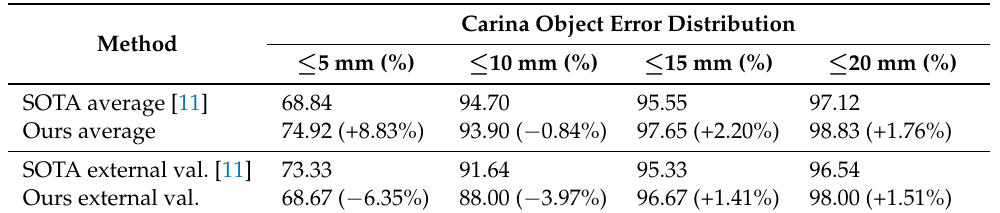
Table 14. The comparison results of error distribution on the